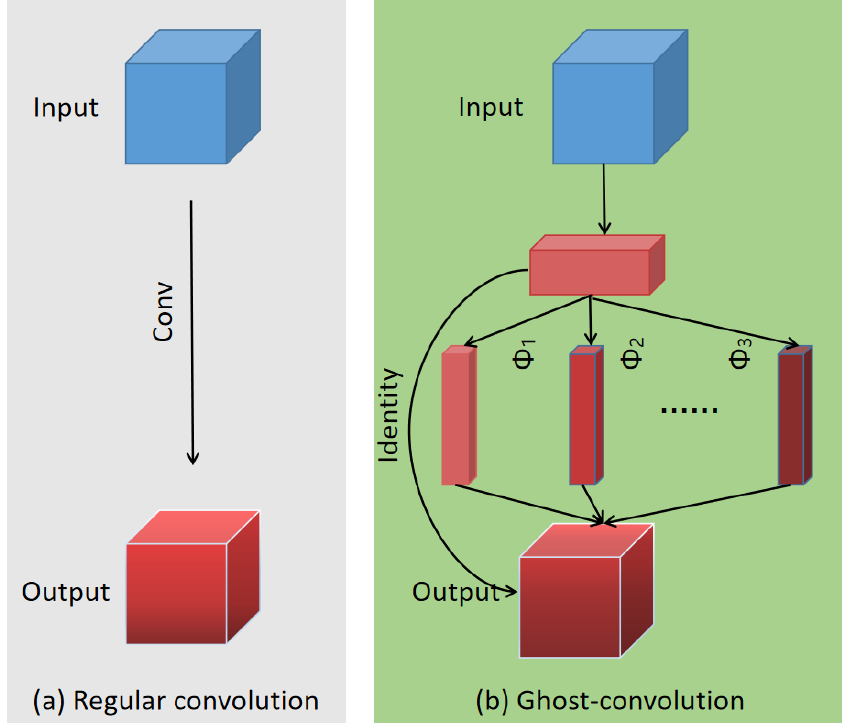
Figure 3. Schematic diagram of the structure comparison between the conventional convolution operation and the Ghost convolution operation. ( a ) Conventional convolution operation; ( b ) Ghost convolution operation.